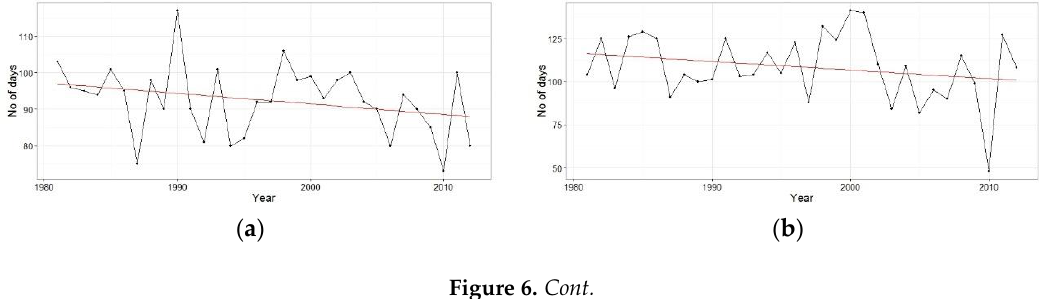
Figure 5. Station-wise precipitation trend at different season in KRB; red symbols represent the decreasing trend whereas the blue indicates the increasing trend.